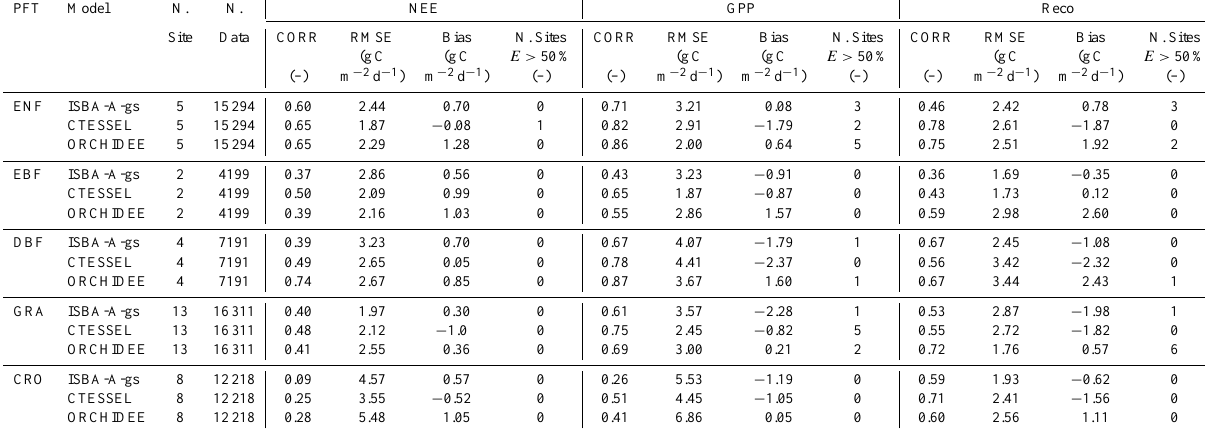
Table 3. Performance of the models (ISBA-A-gs, ORCHIDEE, CTESSEL) in simulating daily carbon fluxes for all PFTs: ENF – evergreen needleleaf forest; EBF – evergreen broadleaf forest; DBF – deciduous broadleaf forest; GRA – grassland; and CRO – cropland. N.Site – number of available sites for each PFT; N.Data – number of available days; CORR – correlation coefficient; RMSE – root mean square error; Bias; N. Sites E > 50% – number of sites with model efficiency ( E ) higher than